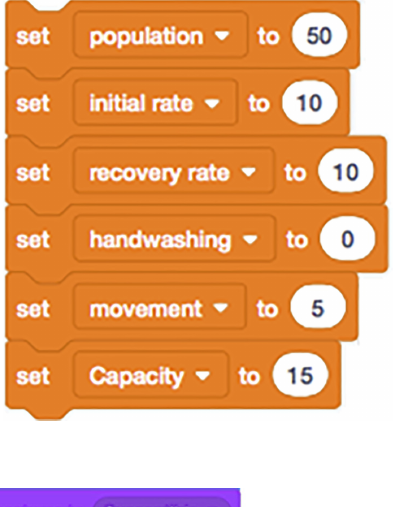
Figure 13. Coding blocks for illustrating the initialization step in